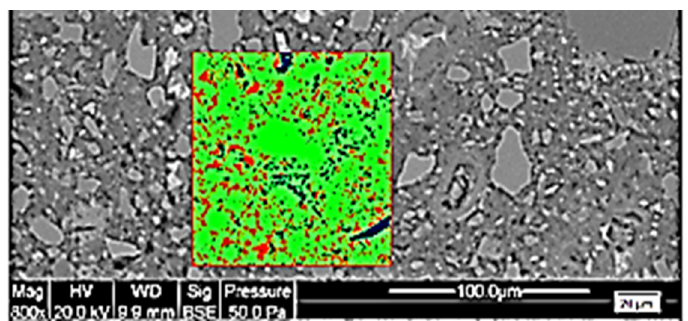
Figure 3. Example of SEM image analysis with a magnification of 800 on a NP0 sample.